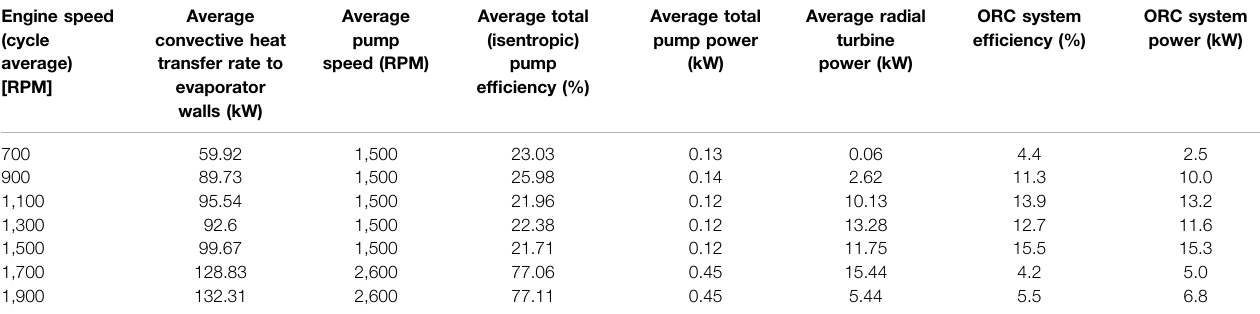
TABLE 2 | (A) Performance of ORC system with radial turbine, (B) Stator and rotor optimized values, (C) Stator main geometric and fl ow angle data and (D) Rotor main geometric and fl ow angle data. Engine speed